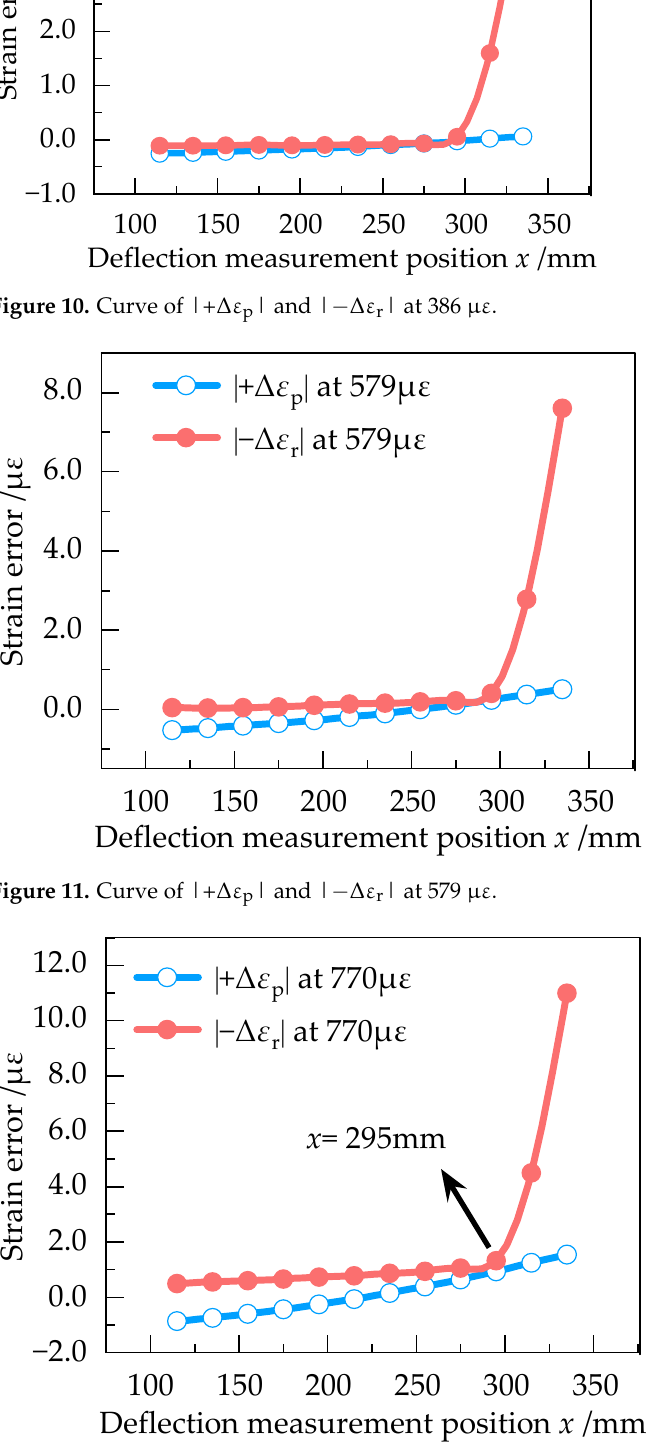
∆ ε ∆ ε Figure 12. Curve of |+ Δε p | and | −Δε r | at 770 με . Figure 12. Curve of |+ Δε p | and | −Δε r | at 770 με . Figure 12. Curve of |+ p | and | − r | at 770 µε Figure 12. Curve of |+ Δε p | and | −Δε r | at 770 με .